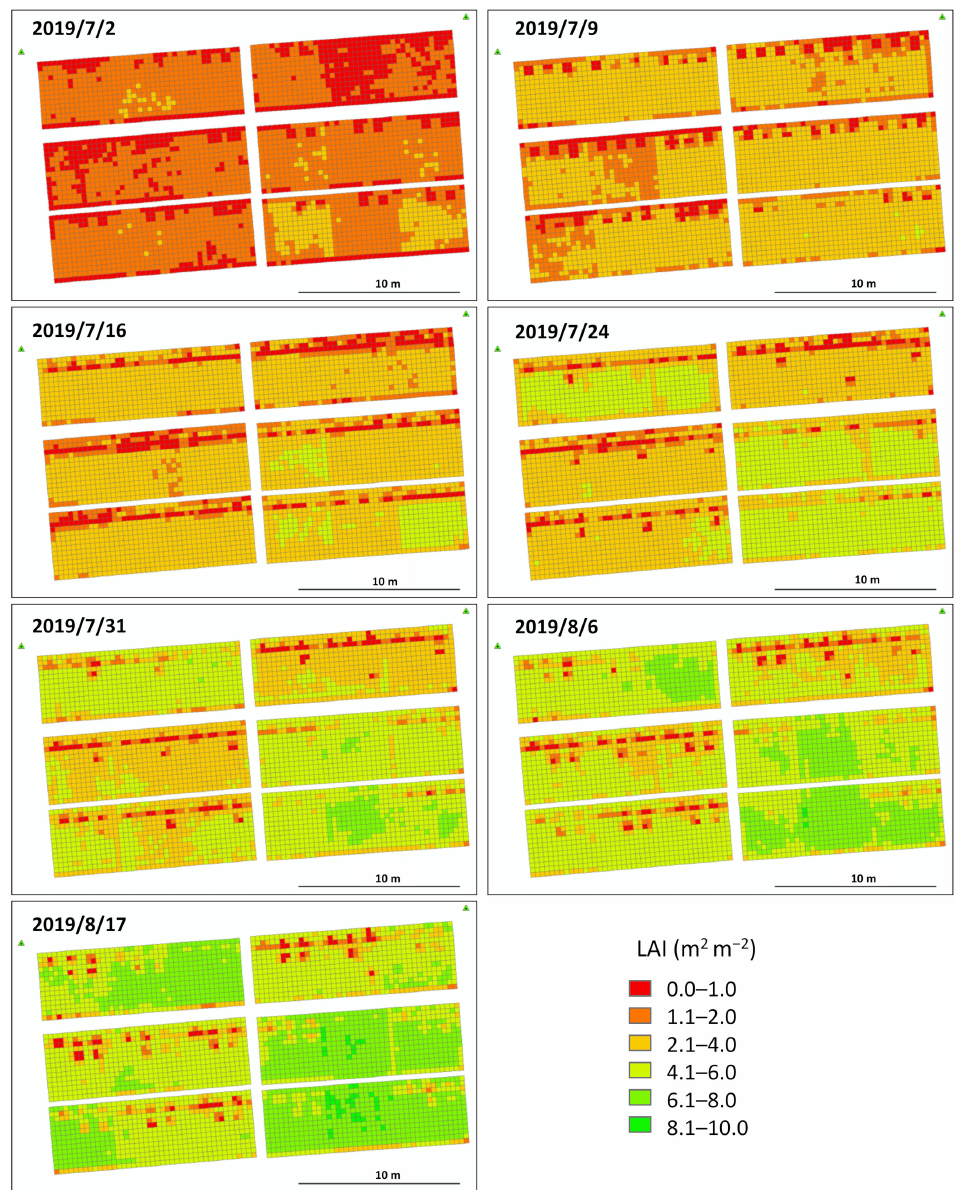
Figure 13. Examples of Spatial estimation of LAI in 2019 using the DSM model (greener areas represent higher